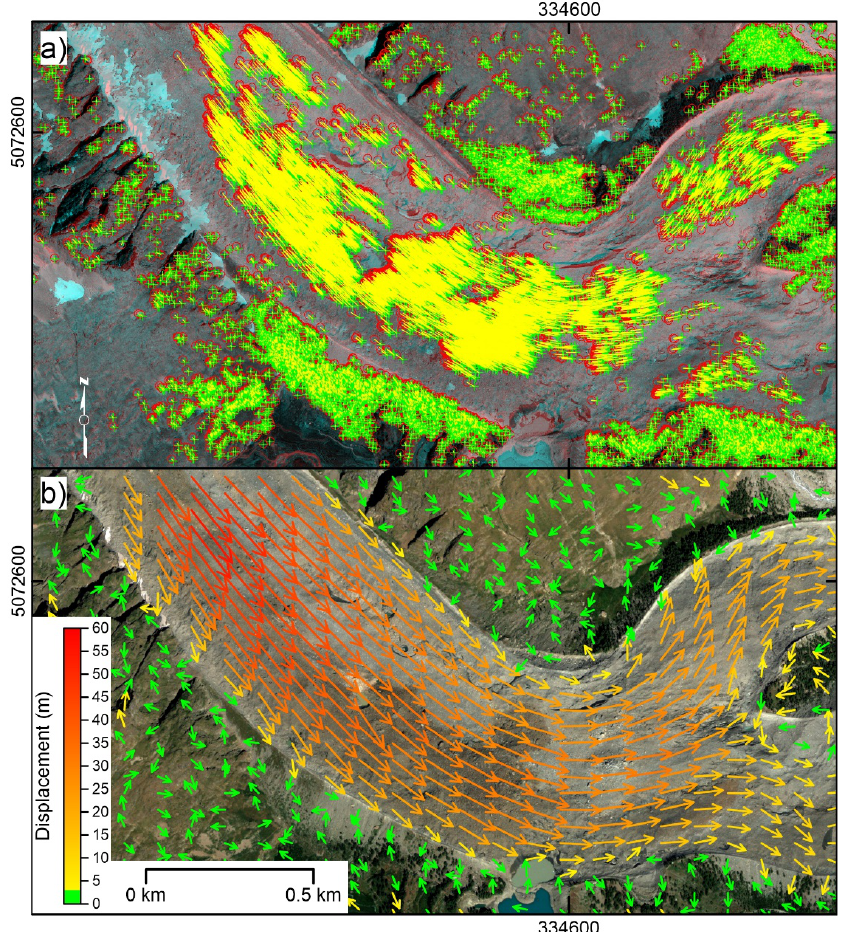
Figure 7. Miage debris-covered glacier and surrounding slopes. ( a ) Eigen features identified and tracked within the study area. Centroid of red symbols indicates feature position in the master image (i.e., 29 August 2009), while green symbols indicate feature position in the slave image (i.e., 28 May 2011). ( b ) Displacement field map derived by eigen-feature tracking after deviation correction. UTM coordinates are shown at figure edges. Map data 2020 © Maxar Technologies.